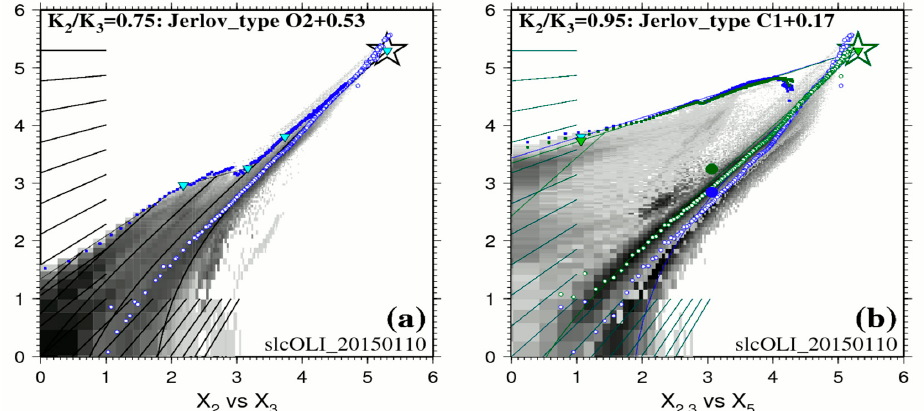
Figure 2. Example of calibration diagram linearized data in logarithmic values for the white ROI of Figure 1. ( a ) is the calibration diagram of linearized Blue (X 2 ) and Green (X 3 ) and reports estimated K 2 /K 3 values with Jerlov water types. ( b ) is the calibration diagram for Blue (X 2 ), Green (X 3 ) and Red (X 5 ) bands respectively. The backdrop in shades of gray represents the bi-dimensional histogram for all image pixels (white ROI in Figure 1). Blue dots are the actual pixels used for BPL calibration, each referenced to its row/line position in the image. Small white circles represent the scatter of averaged bare land pixels, as a proxy for the Soil Line.